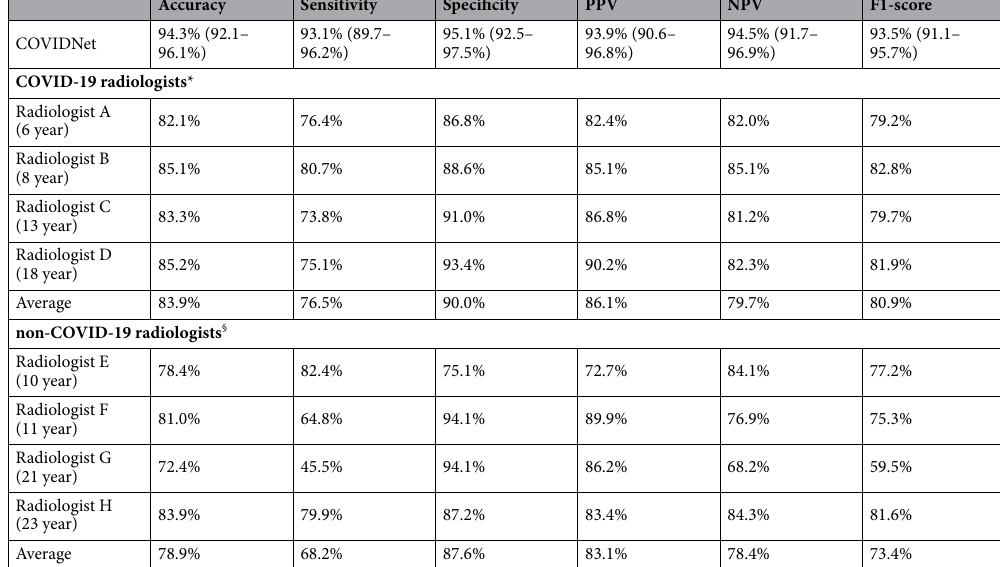
Table 2. Diagnostic performance for each patient among COVIDNet and eight radiologists on the secondary test cohort. Four radiologists were from COVID-19 designated hospitals and the others were not. For COVID- 19 radiologists, radiologist A-D had chest CT image trained experience of 6, 8, 13, and 18 years, respectively. Meanwhile, for the non-COVID-19 radiologist, radiologist E–H had 10, 11, 21, and 23 years of experience, respectively. PPV positive predictive value, NPV negative predictive value. * COVID-19 radiologists : radiologists working at the COVID-19 designated hospitals; § non-COVID-19 radiologists : radiologists not working at the COVID-19 designated